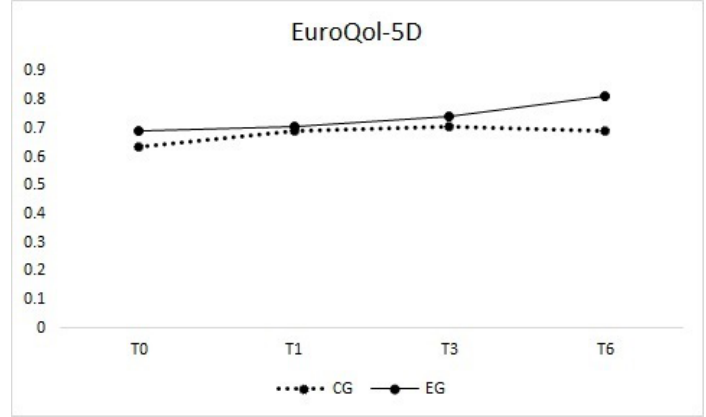
Figure 6. Median scores of EuroQol-5D over time in two treatment groups.